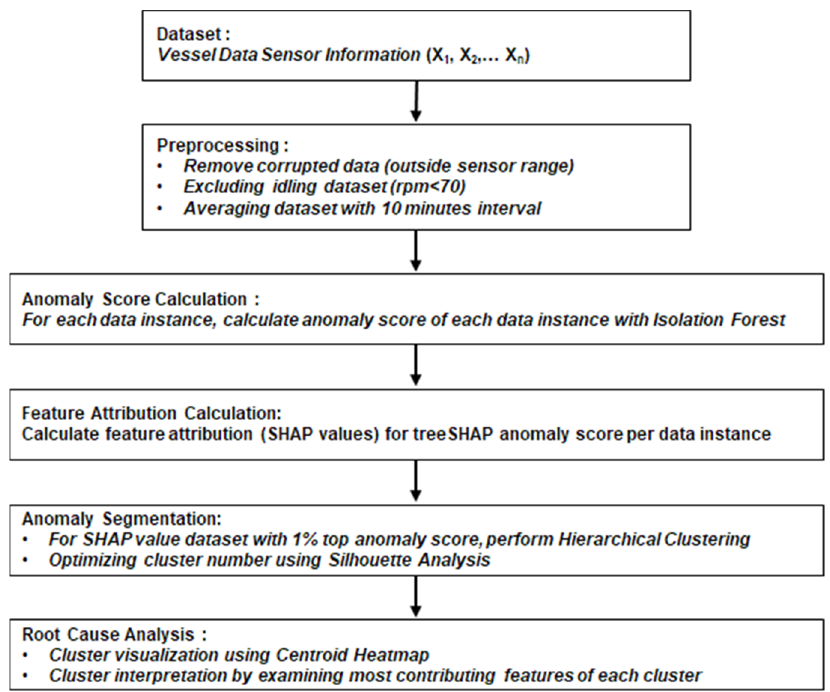
Figure 2. Proposed framework approach.